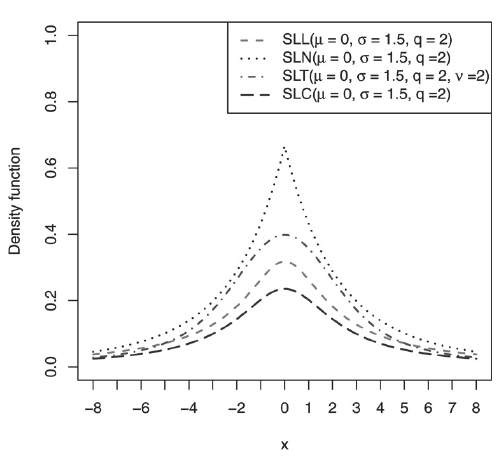
Figure 2 – Slash Laplace density function along with slash normal, slash t and slash Cauchy densi-